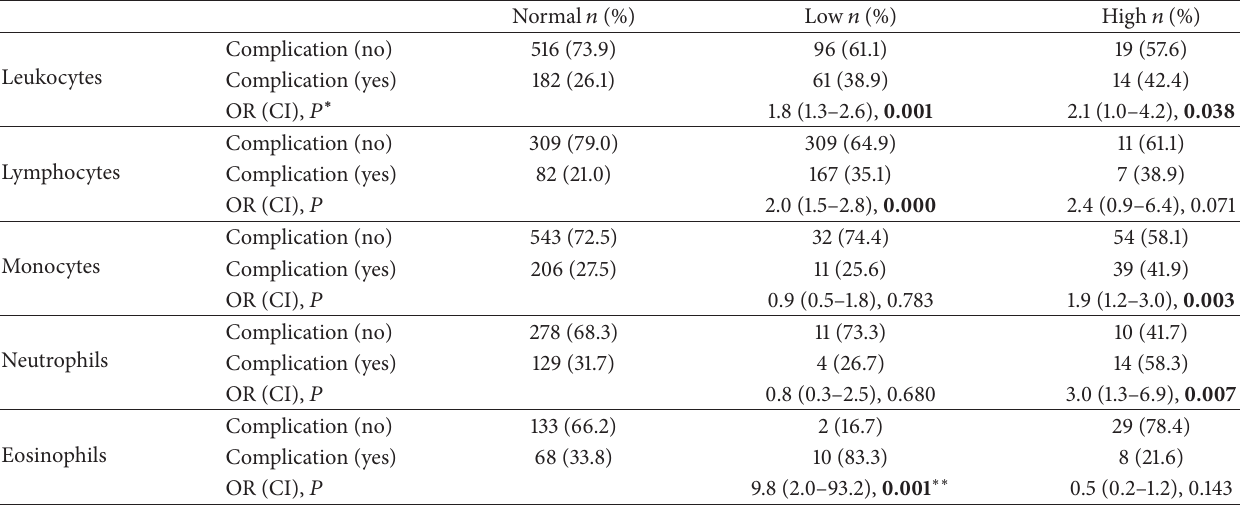
Table 5: Comparison of leukocyte alterations between complicated and noncomplicated